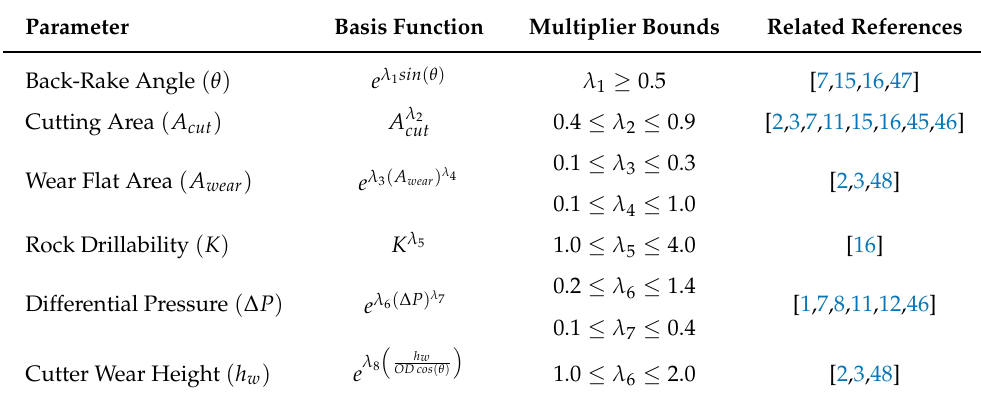
Table 5. Proposed basis regression functions based on experimental observations for F a and F c